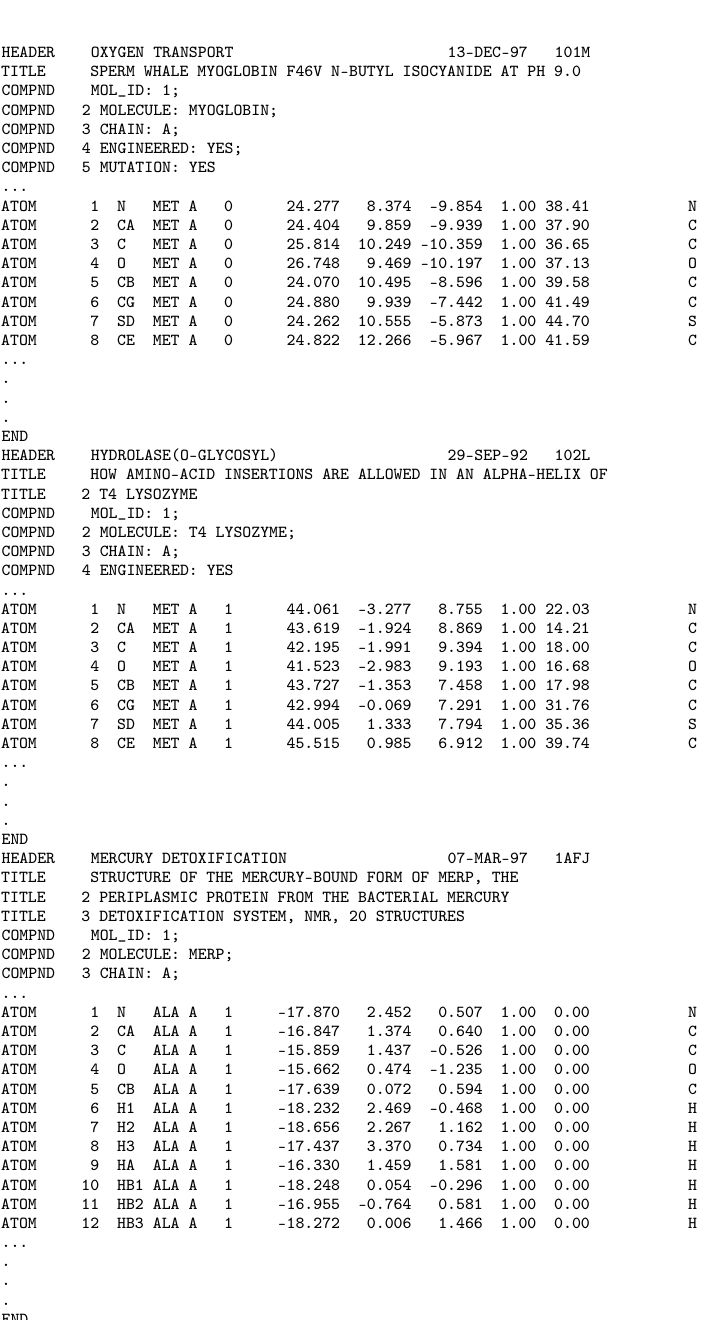
Figure 4. A part of a sample sequential file with many protein structures stored as records for extraction by the PDBUSQLExtractor parallel parser. Each END section determines the border for a single record processed in the U-SQL script for Data Lake Analytics.